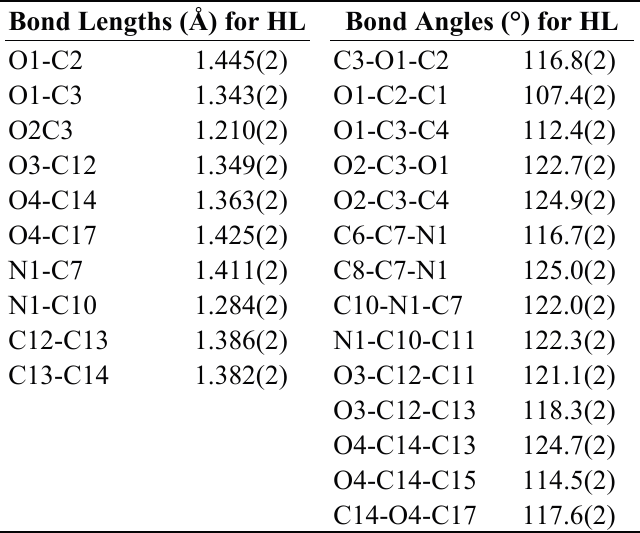
Table 1. Selected bond lengths (Å) and bond angles (°) for HL .